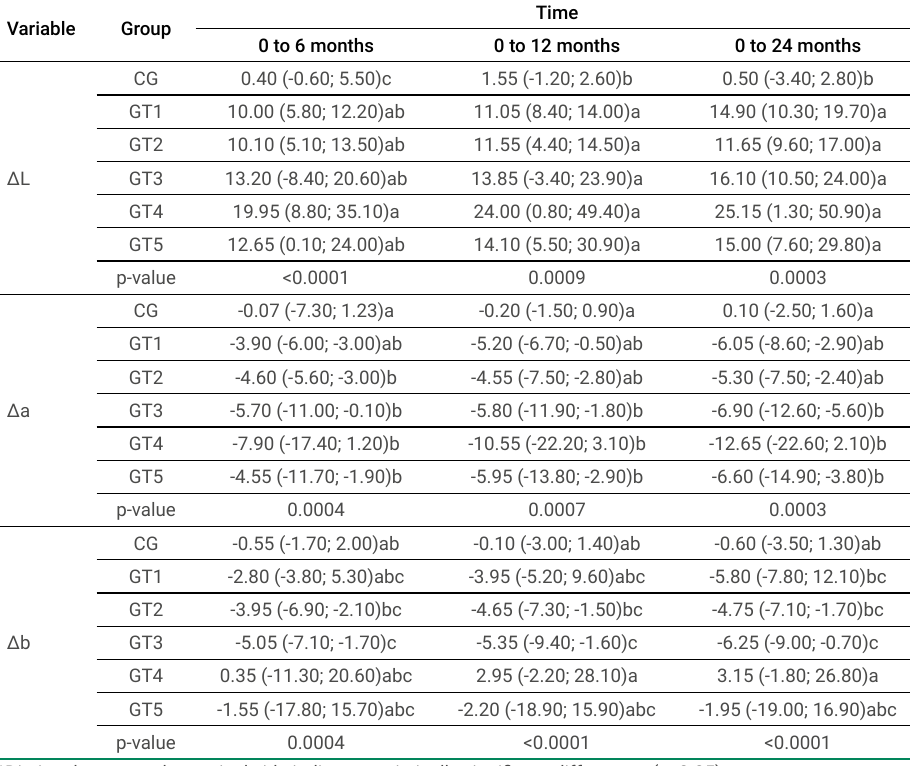
Table 4. Median (minimum; maximum) of the variables relative to color (ΔL, Δa and Δb) in function of group for each time